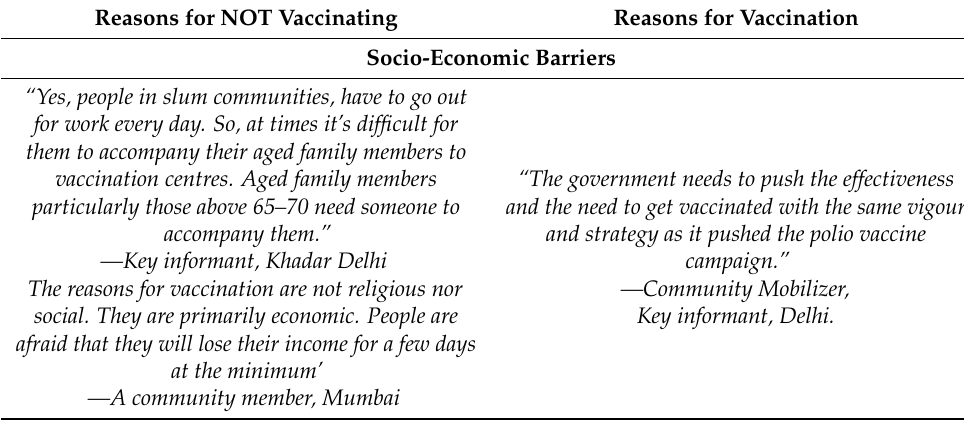
Table 11. Description of theme Socio-economic barrier with